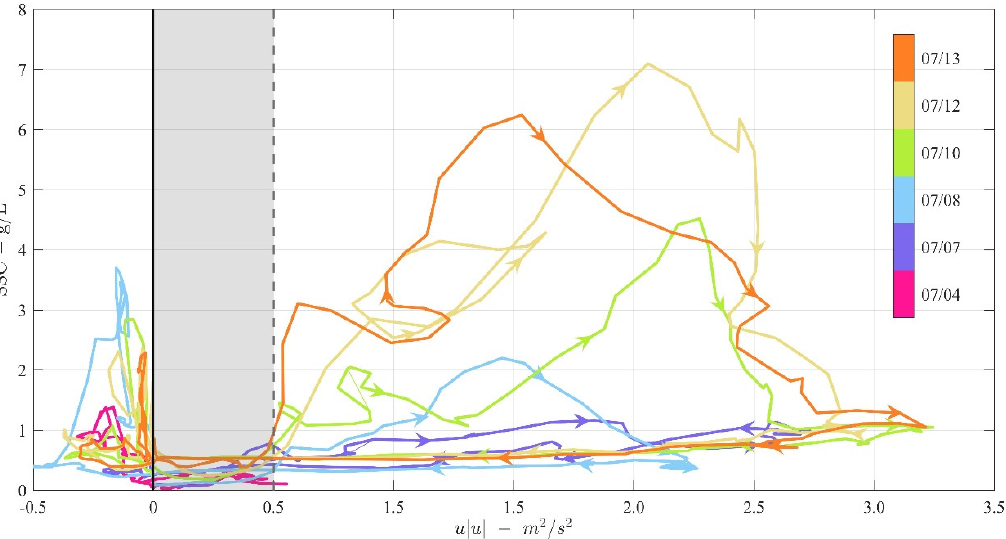
Figure 5. Variation in SSC against the square velocity within each tidal cycle. 𝑢 | 𝑢 | (cid:3408) 0 indicates the ebb